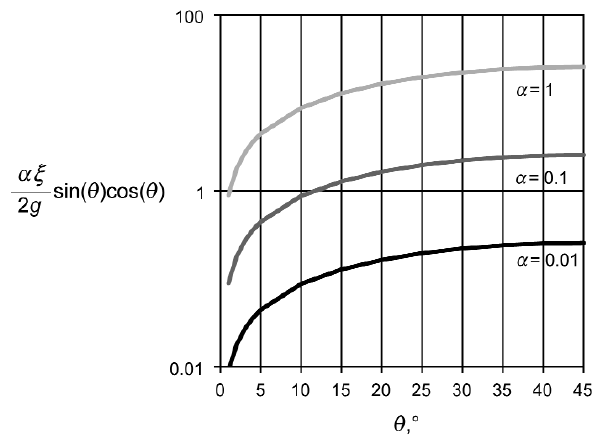
Fig. 4. Implementation of the self-fluidization